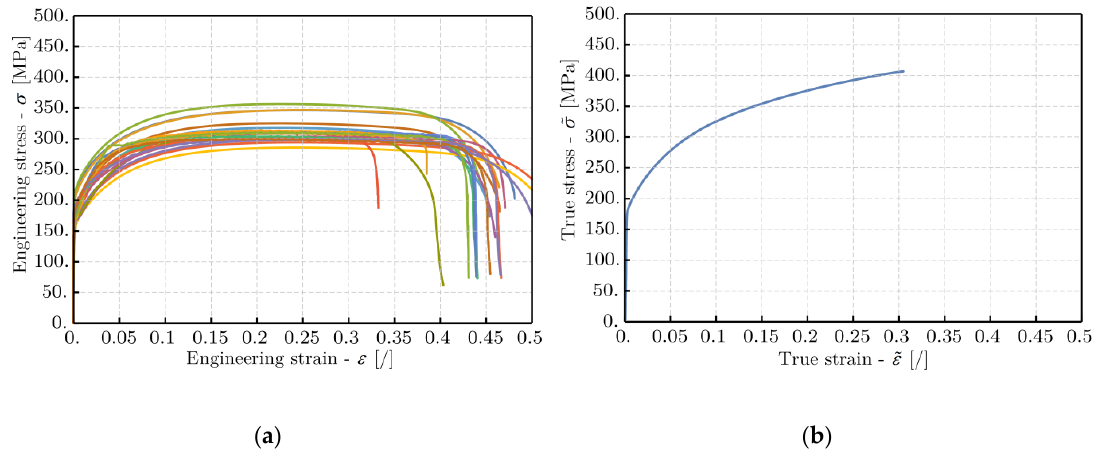
Figure 2. ( a ) Measured engineering stress-strain curves with a controlled loading speed of 100 mm / min at an ambient temperature 20 ◦ C and for di ff erent loading directions in terms of sheet rolling direction (left); ( b ) True-stress vs. true-strain curve from the average measurement results. Table 1. Chemical composition of carbon steel E185 (weight, %). C